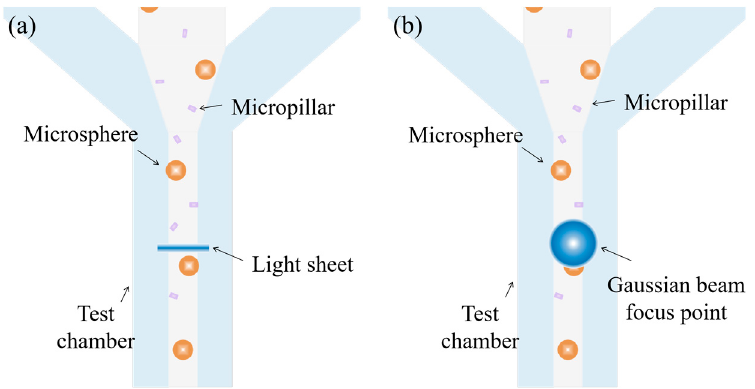
Figure 1. ( a ) Fluorescent micropillars and microspheres passing through a light sheet, and ( b ) fluorescent micropillars and microspheres passing through a Gaussian beam spot.